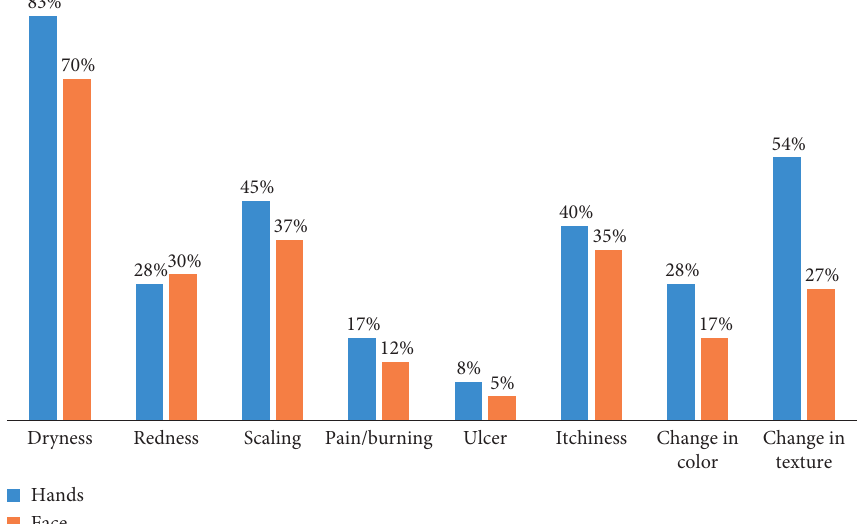
Figure 1: Skin conditions on hands and the face during the pandemic ( n � 2356).